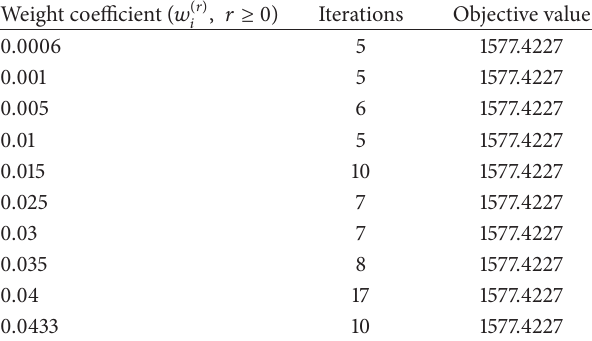
Table6:Comparisonsofeffectsof10differentweightingcoefficients on the proposed